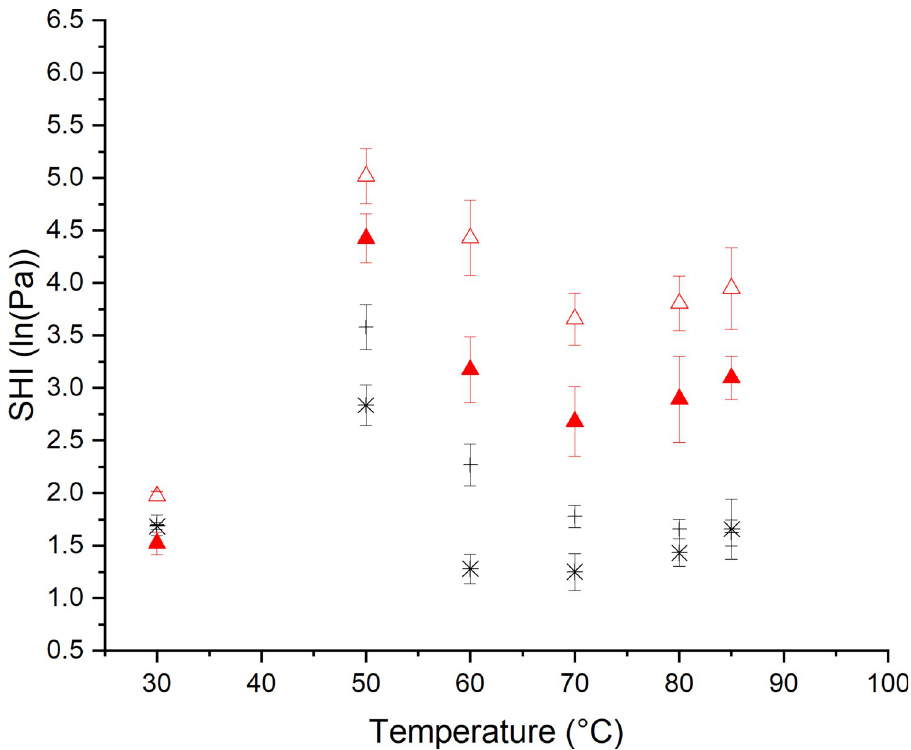
Fig 5. Strain hardening behavior of non-yeasted and yeasted dough after 60 min fermentation and subsequent heating to the specified temperatures. ( � ) Standard non-yeasted wheat dough, _ ε